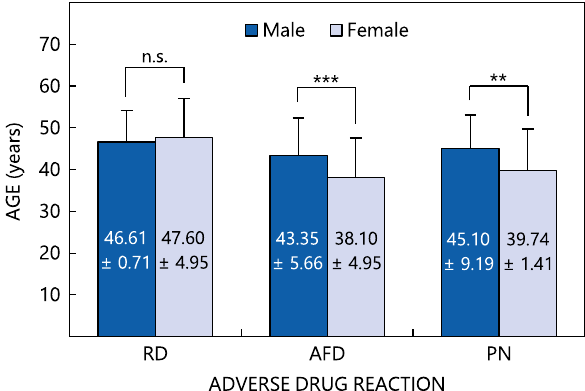
Figure 3: Gender comparison of the mean age (±SD) in terms of the highest reported